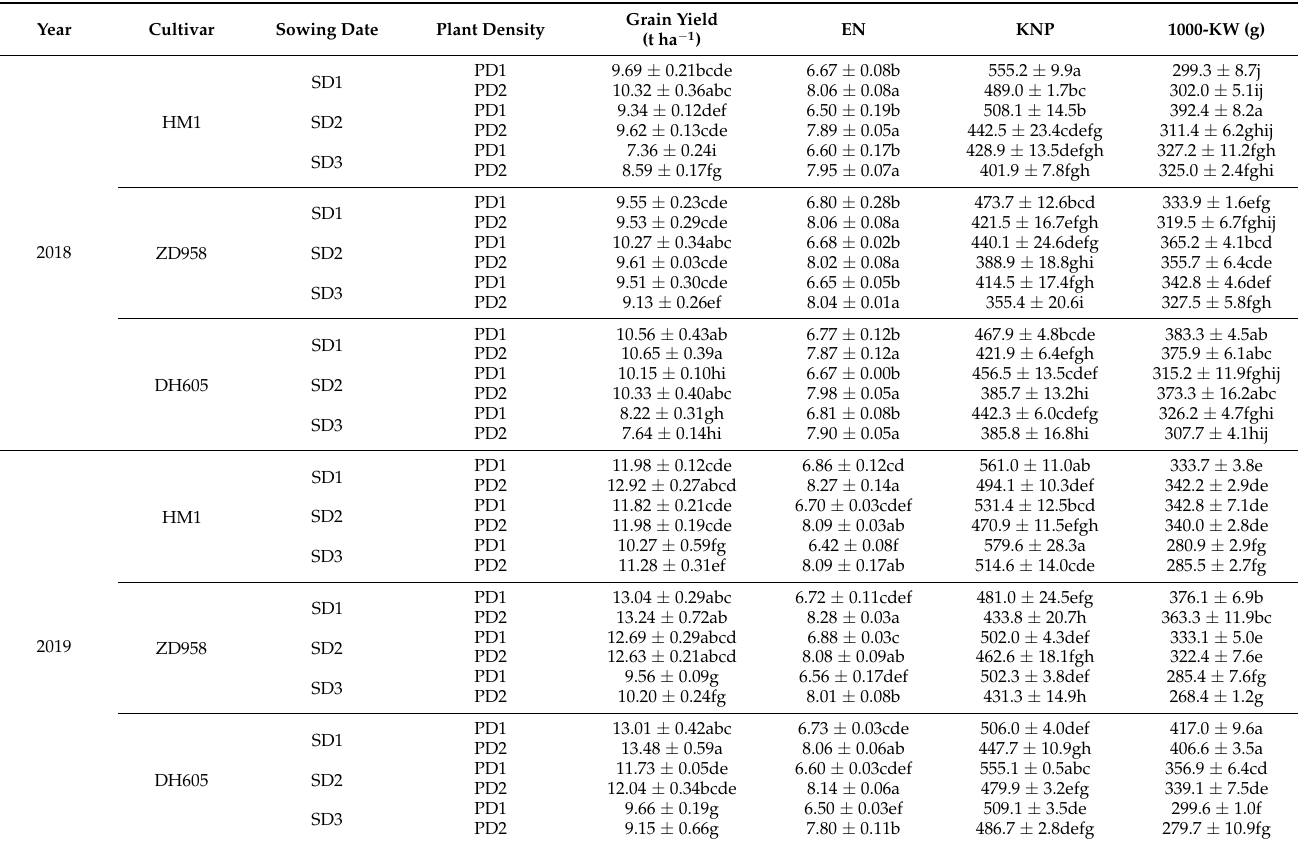
Table 3. Effects of cultivar, sowing date and plant density on grain yield and yield components of maize cultivars differing in maturity.